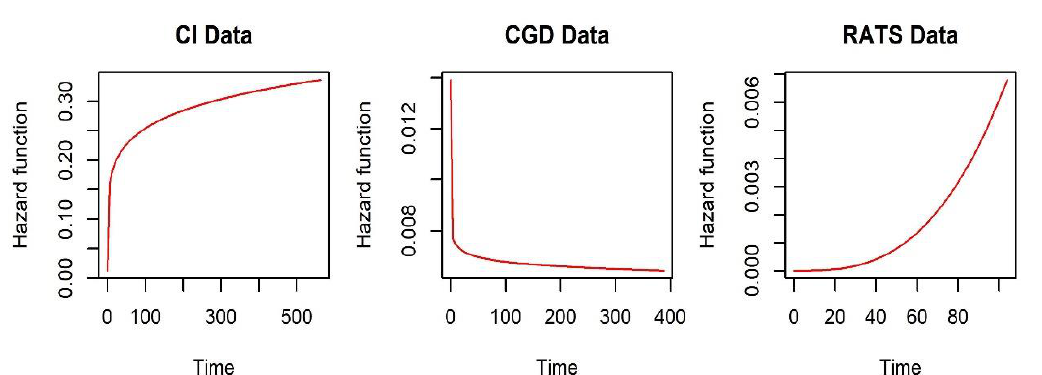
Figure 2. Predicted hazard function plots for the datasets modelled on a Weibull baseline under a shared gamma frailty